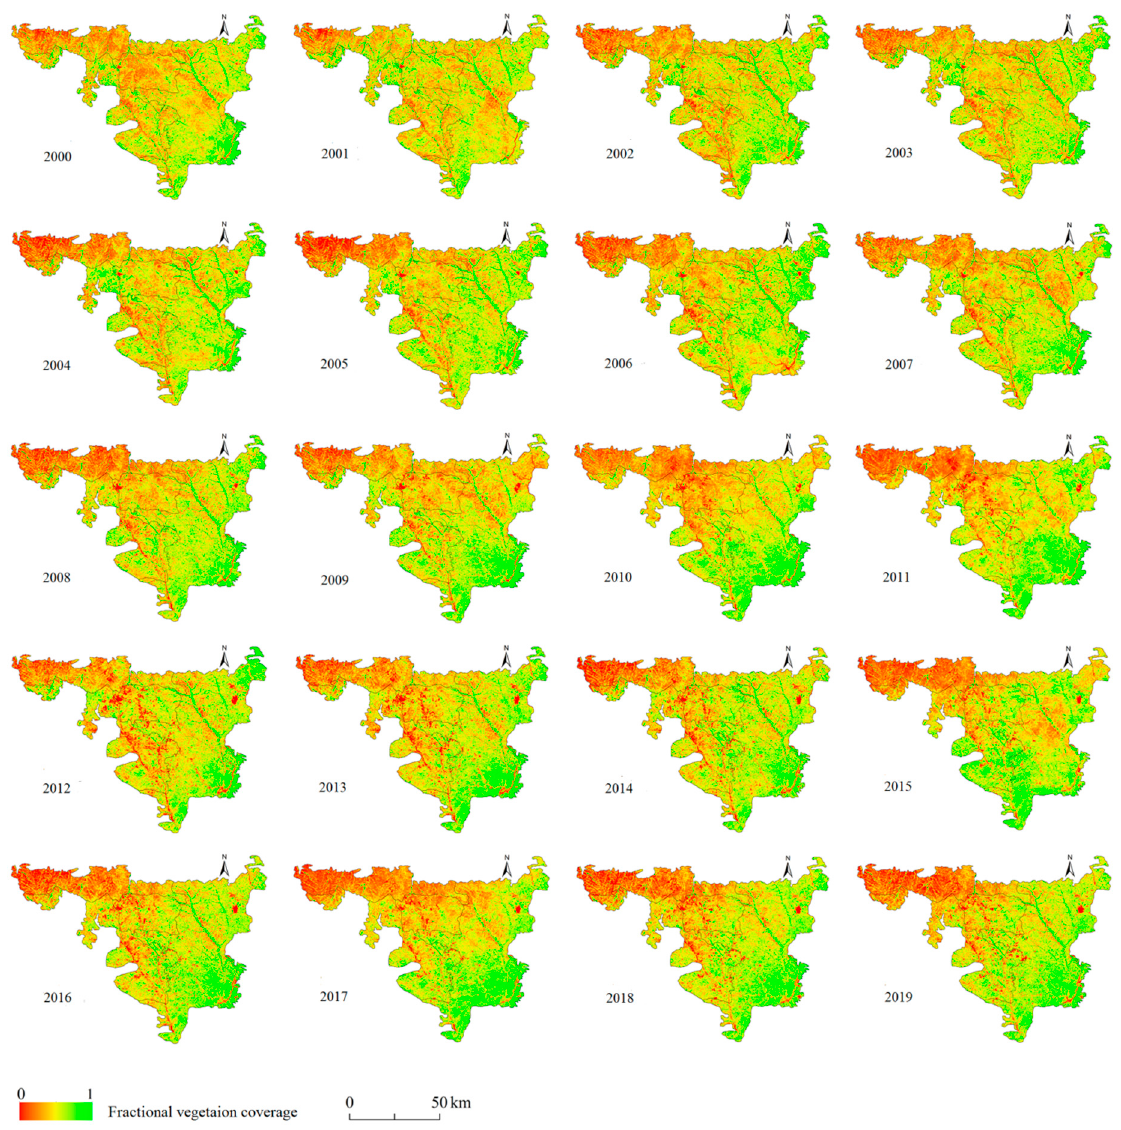
Figure 3. Fractional vegetation coverage of Pisha Sandstone area from 2000 to 2019.